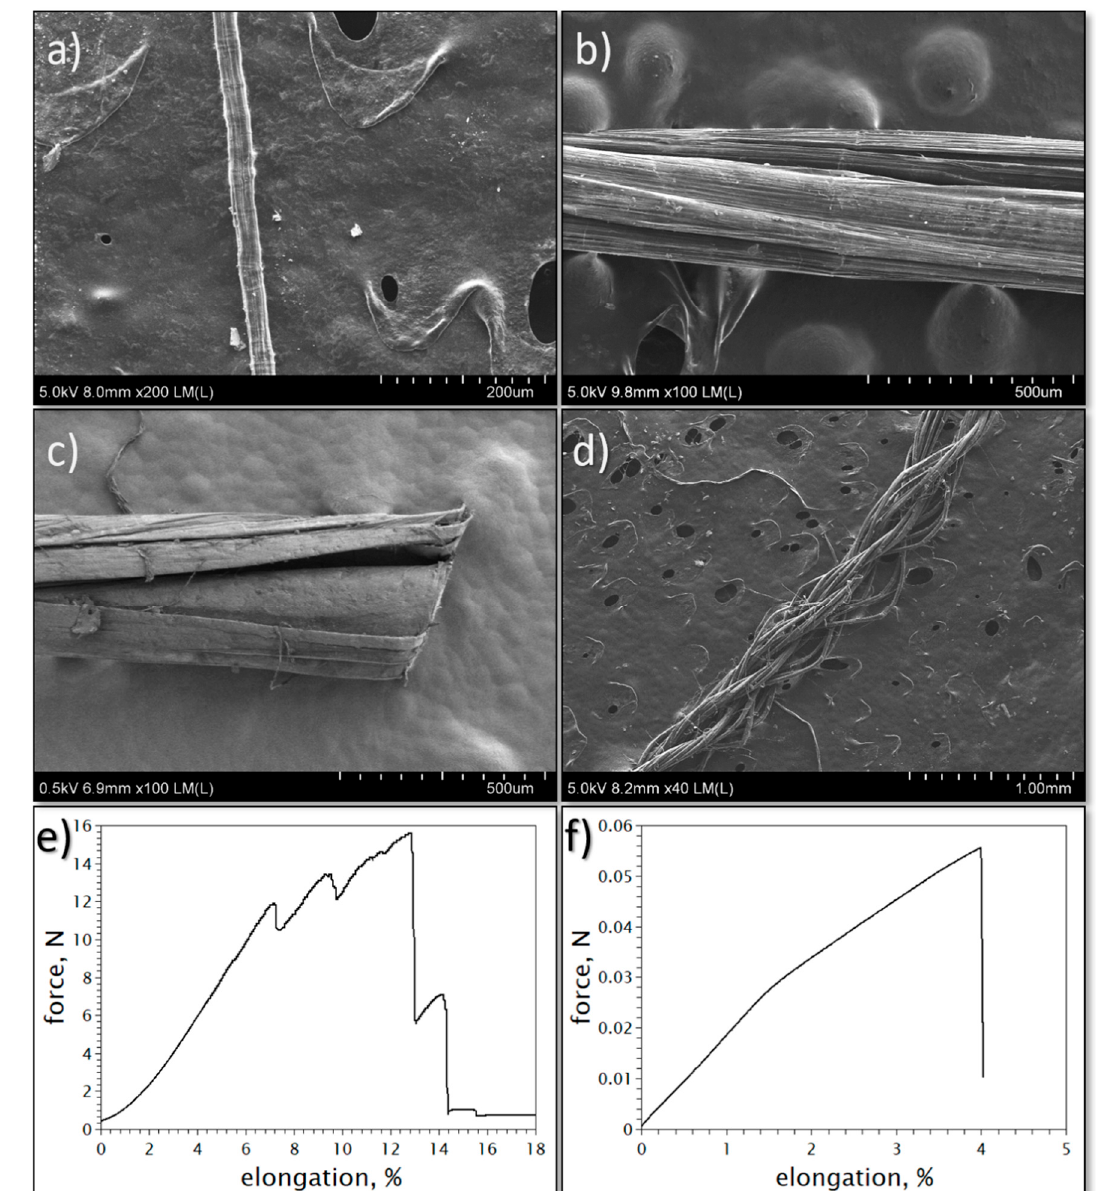
Figure 3. ( a ) A single filament CNT fiber. Larger diameter CNT fibers are made by mechanical and solvent densification of ( b ) many individual fiber filaments, ( c ) by scrolling and solvent densification of CNT film, as well as ( d ) a fiber made by braiding of many individual filaments. Stress–strain curves of fibers: ( e ) fibers made using many individual filaments, compared to ( f ) a single filament CNT fiber.